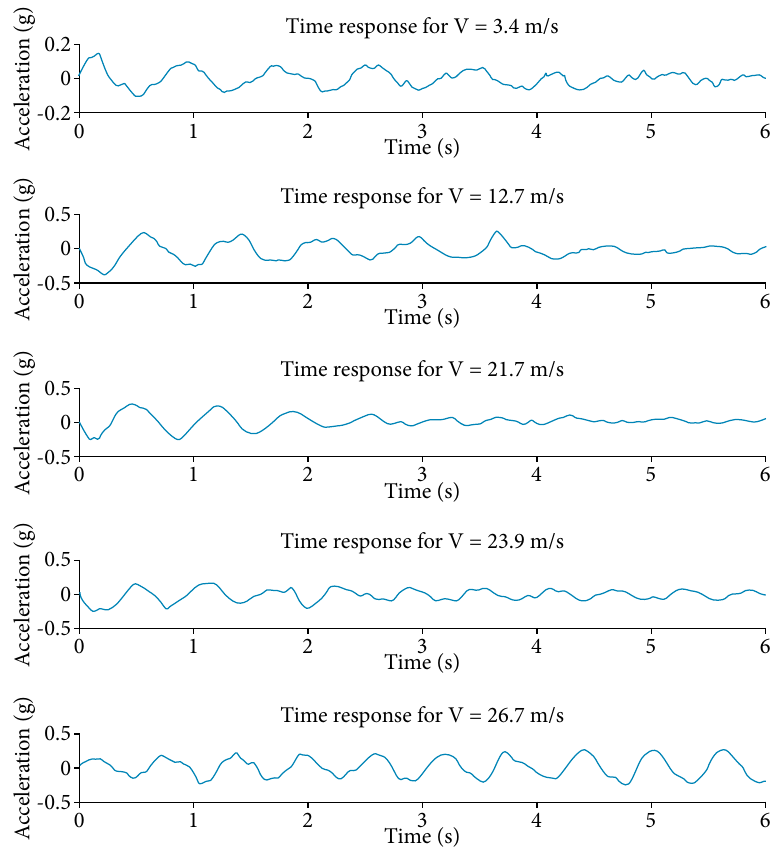
Figure 11. Time response for some of the tested speeds.